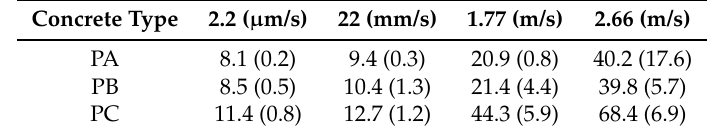
Table 4. The measured first-crack strength, f R , in MPa, at four different loading-displacement rates for concrete PA, PB and PC.